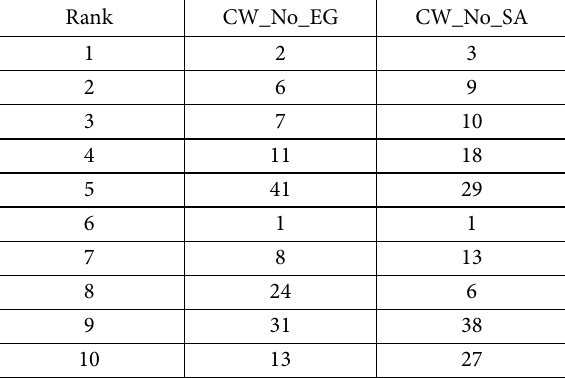
Table 12. Top ten wastes in Egypt and KSA